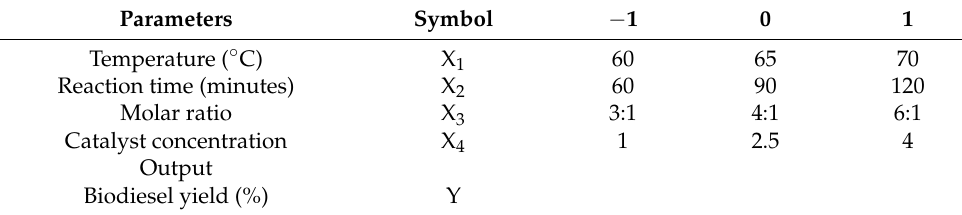
Table 1. Response Surface Methodology experiment range and